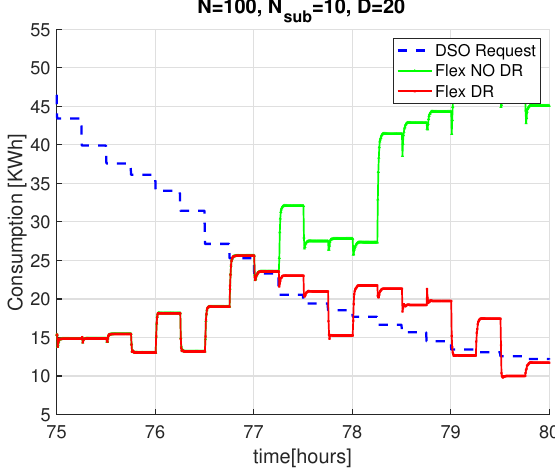
Figure 10. Detailed results of the quantized DSO Adaptation, with subnodes n = 10 and graph degree D = 20.